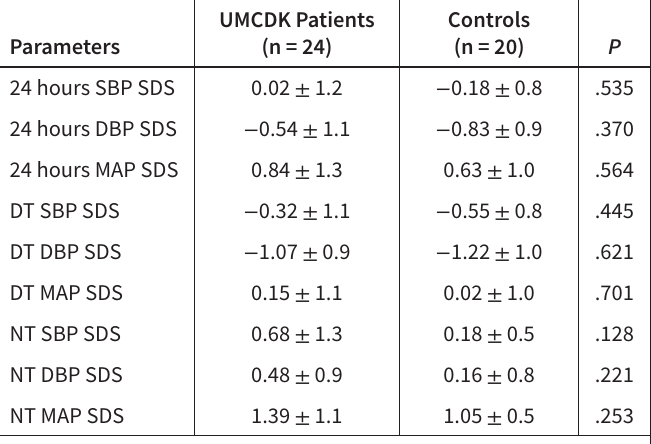
Values are expressed as mean ± SD. P value is for comparison between control and UMCDK patients (unpaired t test), P < .05 is significant. DBP, diastolic blood pressure; DT, day-time; MAP, mean arterial pressure; NT, night-time; SDS, standard deviation score; SBP, systolic blood pressure; UMCDK, unilateral multi-cystic disease of